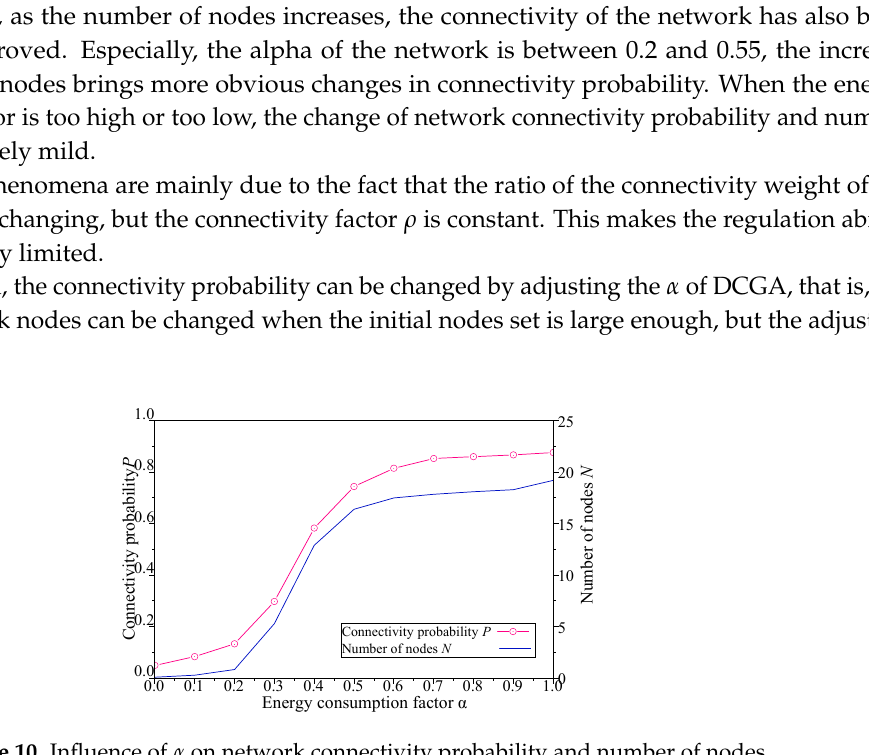
Table 3. Parameters of Scenario 2.